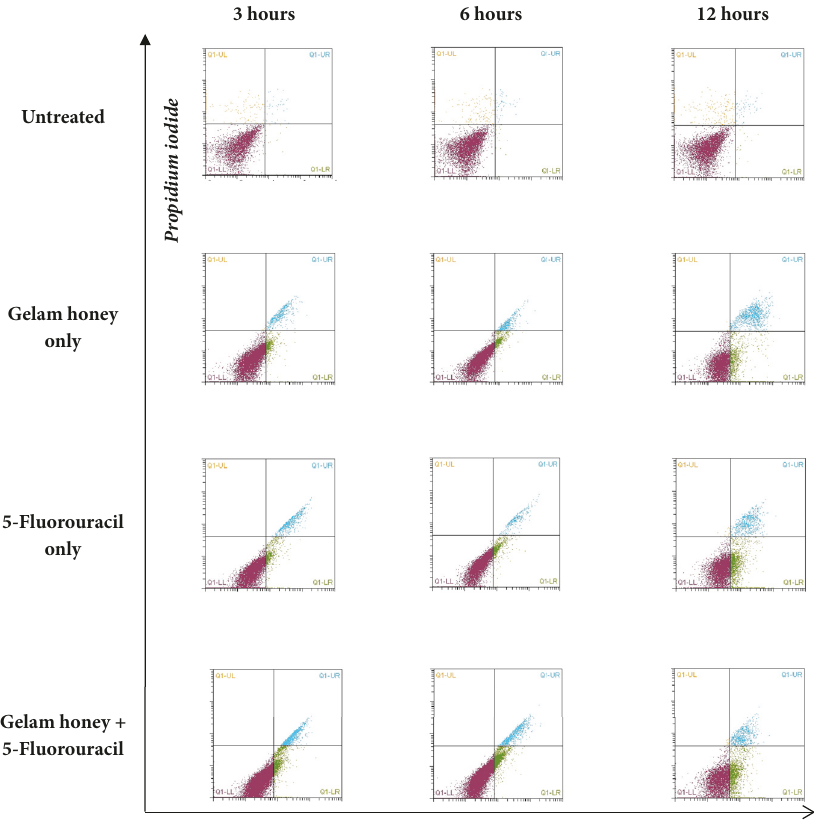
Figure 7: Flow cytometry analysis of untreated and CD 50 -treated HT-29 cells via staining with Annexin V FITC/propidium iodide (PI). Viable cells are in the lower left quadrant, early apoptotic cells are in the lower right quadrant, late apoptotic cells are in the upper right quadrant, and nonviable necrotic cells are in the upper left quadrant. Each dot in the plot represents 10,000 cells in a single